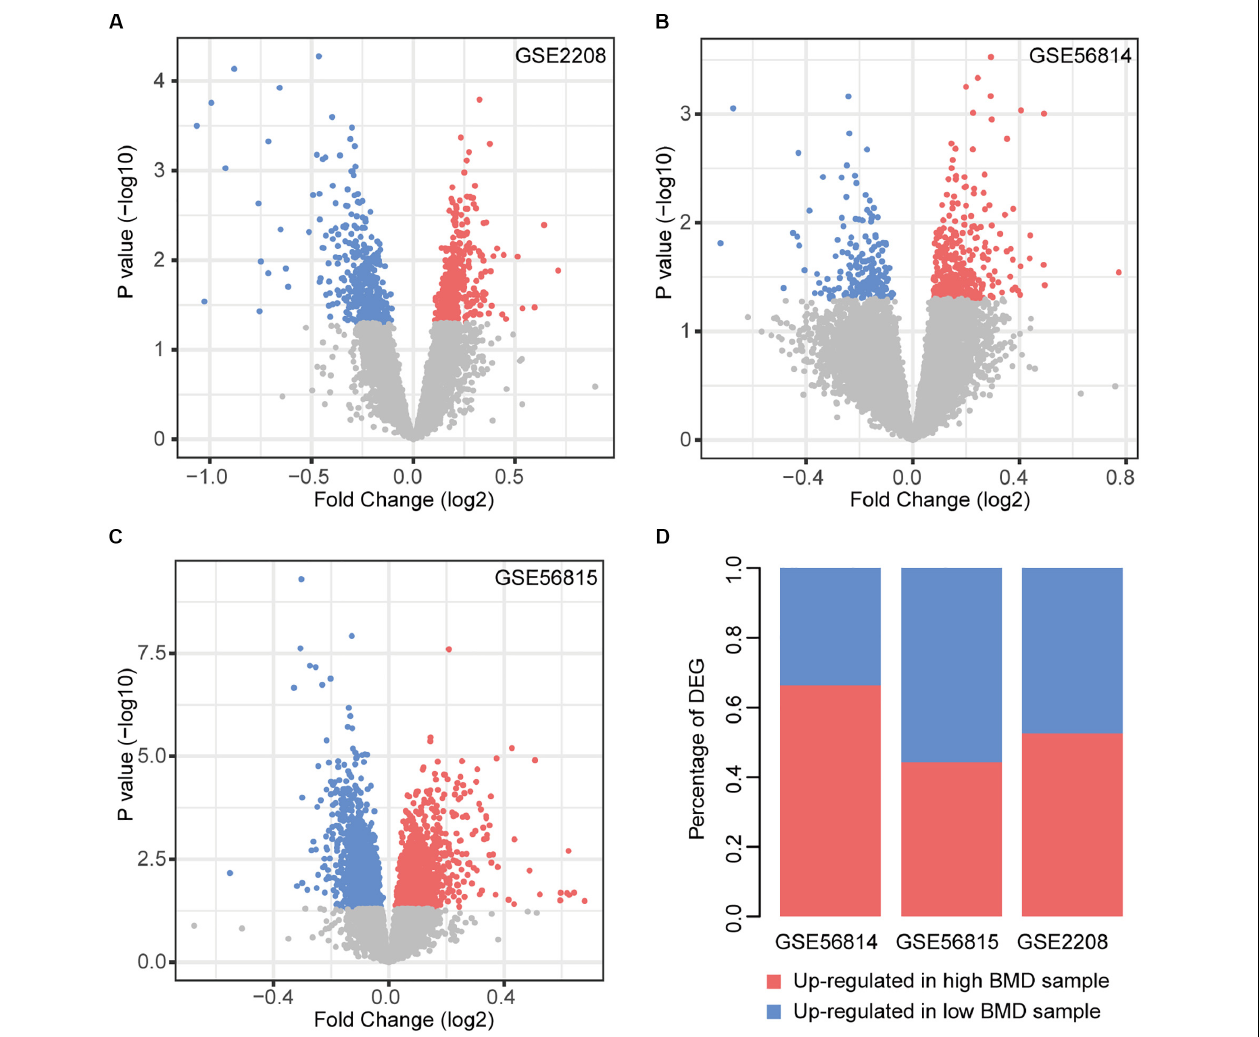
FIGURE 1 | Differential expression analysis. (A–C) Volcano plot of DEGs in each dataset, red nodes represent upregulation in high BMD samples and blue nodes represent upregulation in low BMD samples. (D) Statistics of two types of